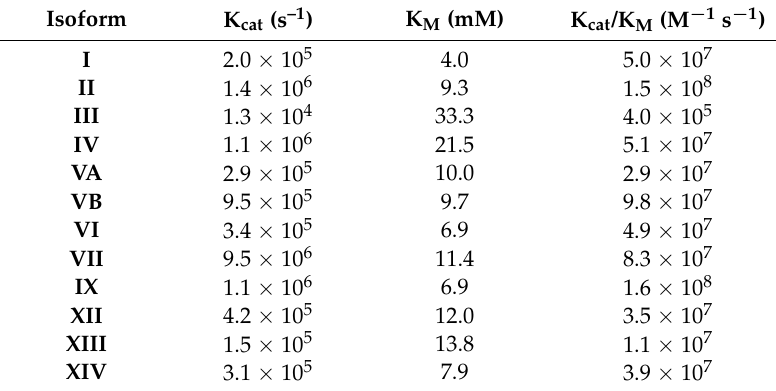
Table 2. Catalytic efficiency of the CA